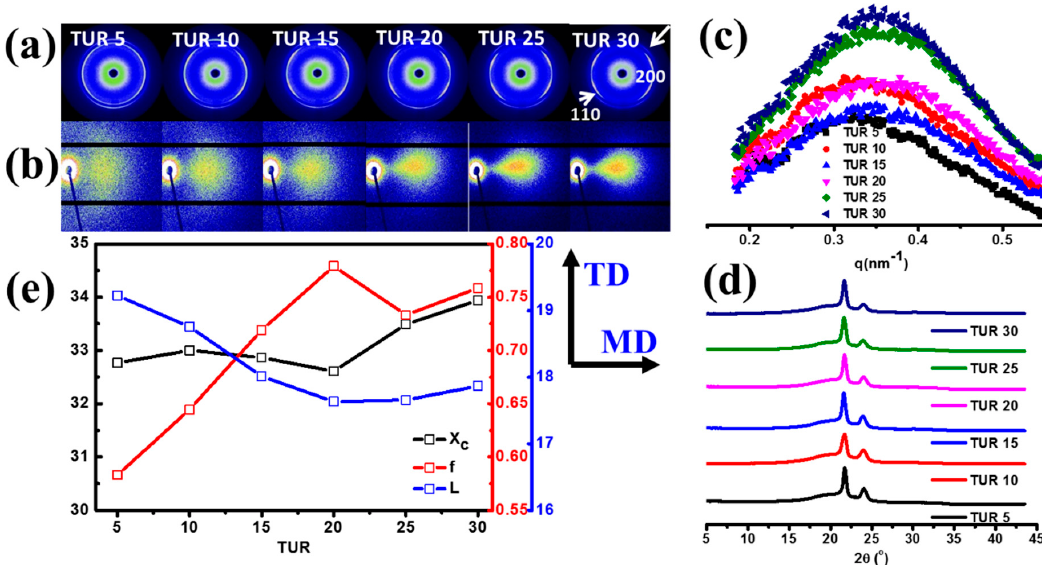
Figure 7. (a) Ex situ 2D WAXS diffraction images; ( b ) 2D-SAXS scattering patterns, the machine direction (MD) is horizontal; ( c ) the 1D integrated SAXS curves; ( d ) 1D integrated WAXS curves; ( e ) the crystallinity χ c (%), orientation factor f, and long period L (nm) calculated from the WAXS and SAXS 1D curves, respectively, at various TURs.